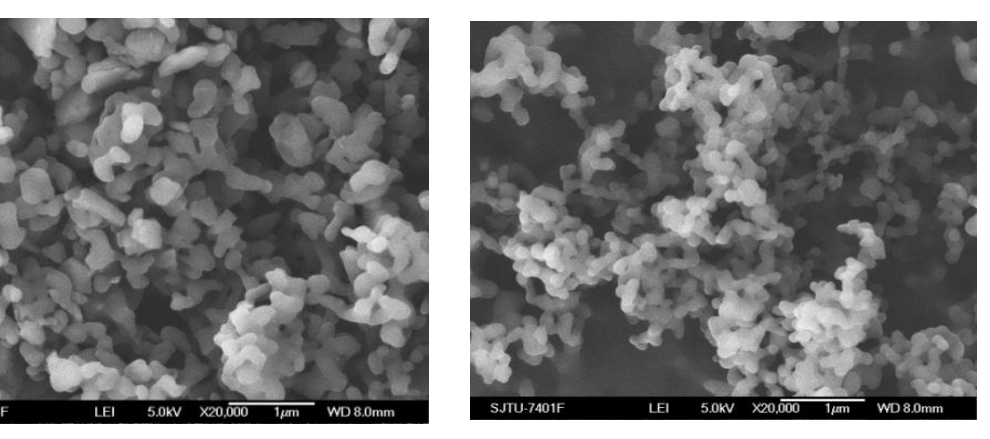
Figure 1. SEM images of nanoparticles prepared by SEDS process with different pressures.